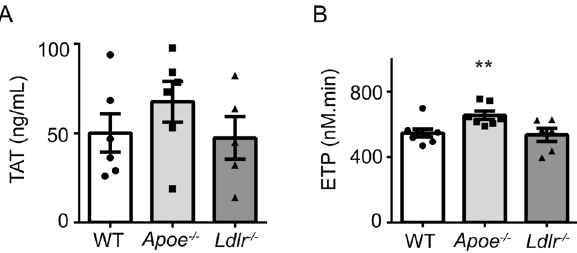
Figure 3. No relevant differences in coagulation parameters measured in plasma from Apoe −/− and Ldlr −/− mice. ( A ) Circulating thrombin-antithrombin (TAT) complexes measured in plasma from wild-type, Apoe −/− and Ldlr −/− mice on normal chow diet. Means ± SEM ( n = 5–6 animals/group, Mann–Whitney U test). ( B ) Thrombin generation in plasma from Apoe −/− and Ldlr −/− mice. Calibrated automated thrombin generation was assessed at 1 pM tissue factor (f.c.) in platelet-free plasma from wild-type, Apoe −/− and Ldlr −/− mice. Standard curve parameters were recorded: shown is endogenous thrombin potential (ETP, area-under-the-curve) as means ± SEM ( n = 6–8). ** P < 0.01 vs. wild-type (Mann–Whitney U test). Lag time to initial thrombin, thrombin peak height, and time-to-thrombin peak were not significantly different between groups (not shown).